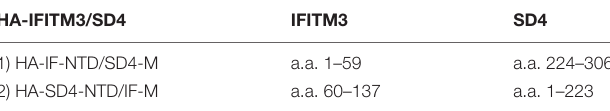
TABLE 3 | GluK2/GluA2